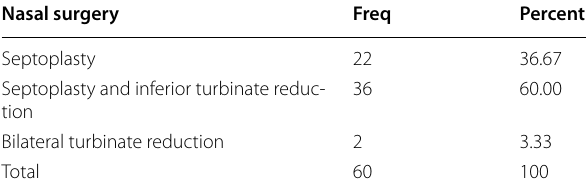
Table 3 Pre‑ and post‑operative SOS, SBPS, and ESS scores in OSA patients who underwent staged and single‑stage multilevel surgery